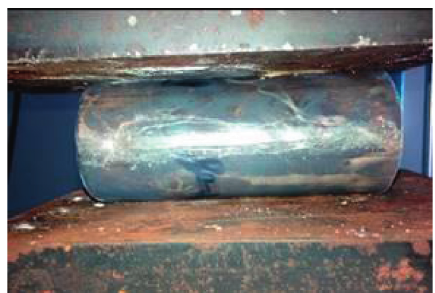
Figure 1: The induced fracture diagram of the Brazil splitting method.